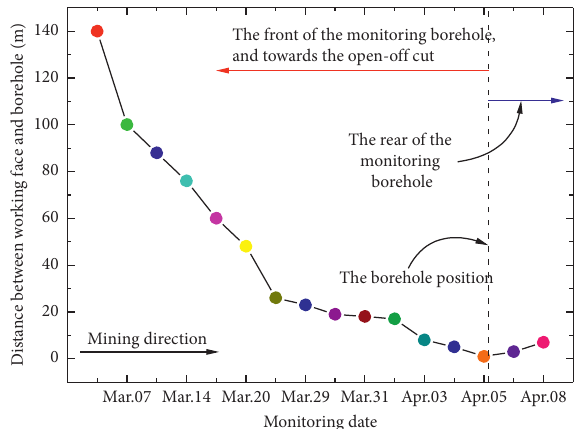
Figure 2: Spatiotemporal relationship between working face and monitoring borehole.